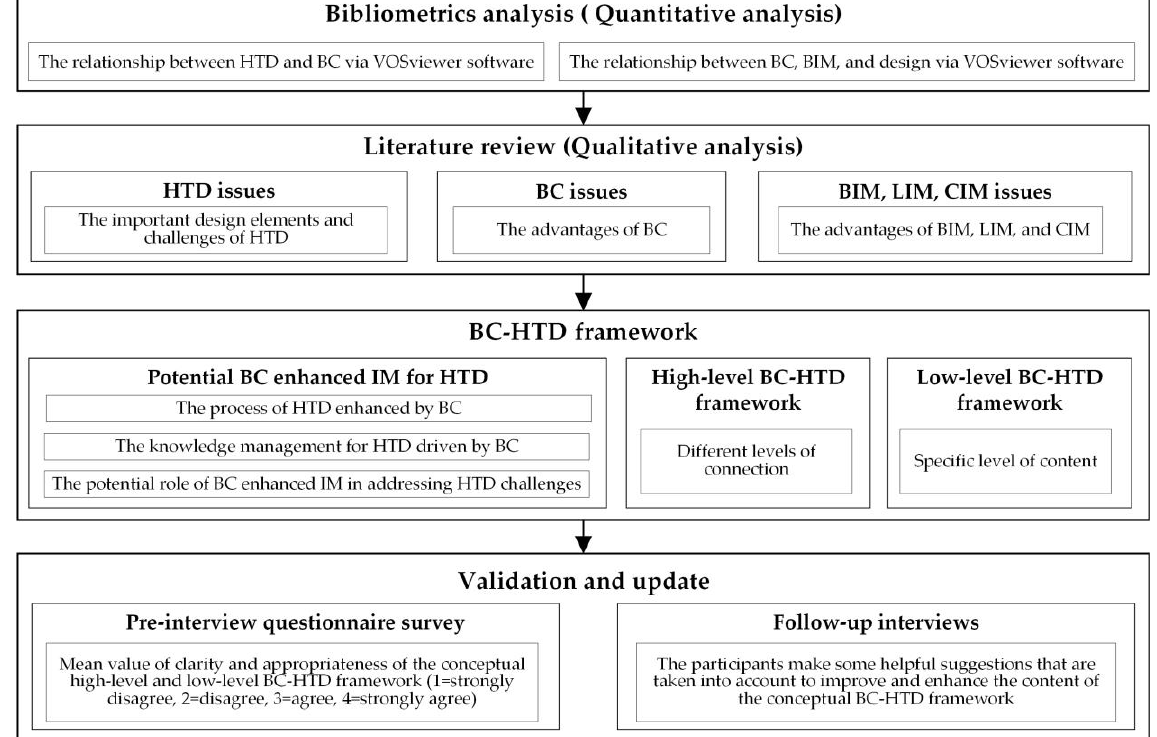
Figure 8. The conceptual BC-HTD framework design and development flow chart (generated by authors).